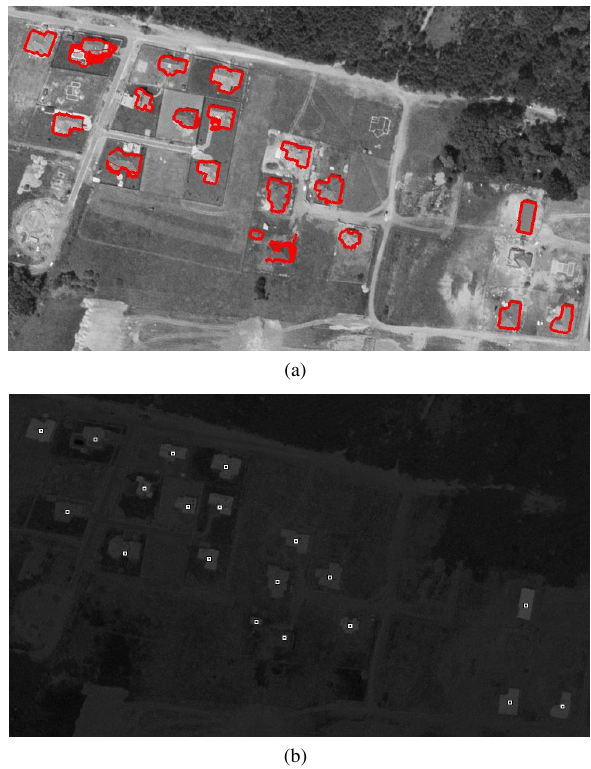
Figure 6: Result of the building detection: (a) shows the detected contours; (b) is the estimated locations of the detected buildings.